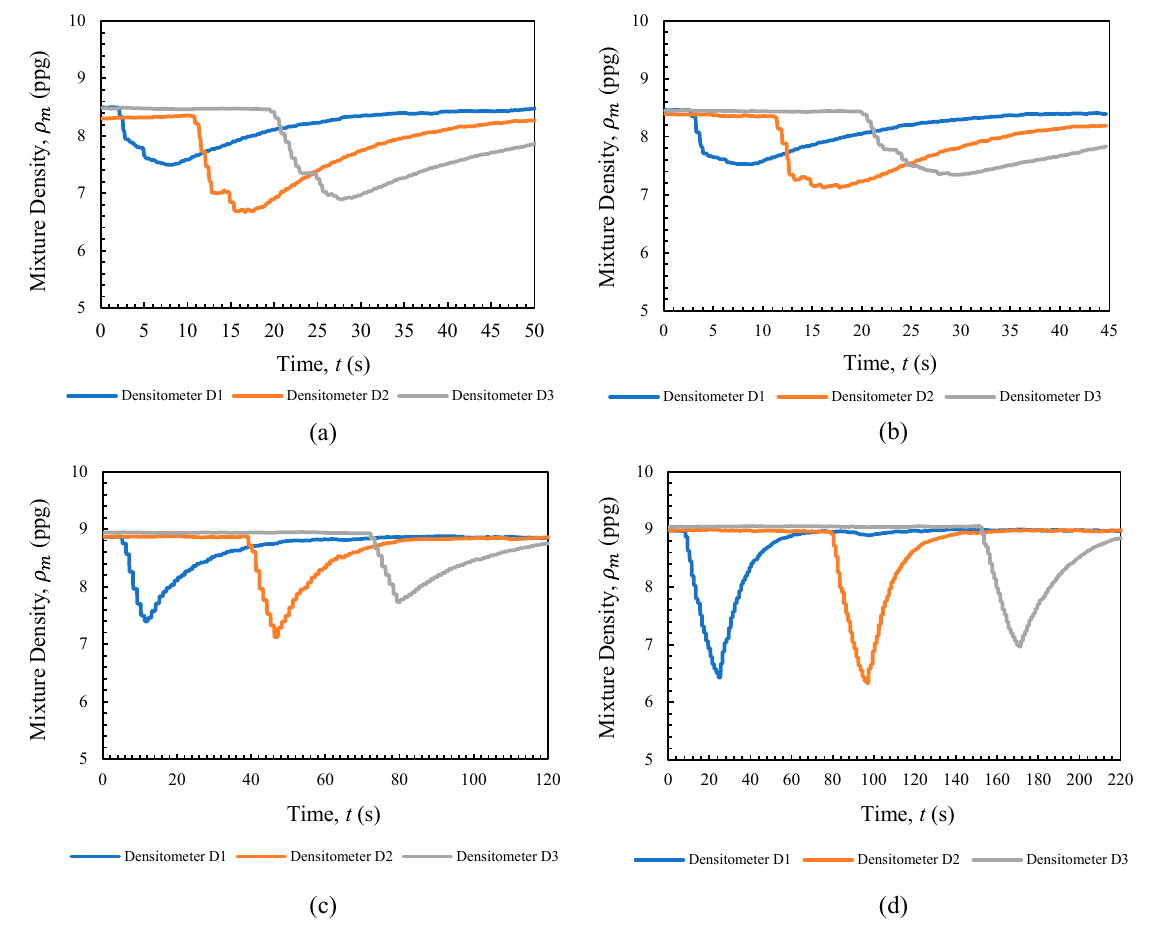
Figure 10. Air–liquid mixture density ( ρ m ) change with time at 45 ◦ from vertical. ( a ) 10 lb/bbl BW; ( b ) 30 lb/bbl